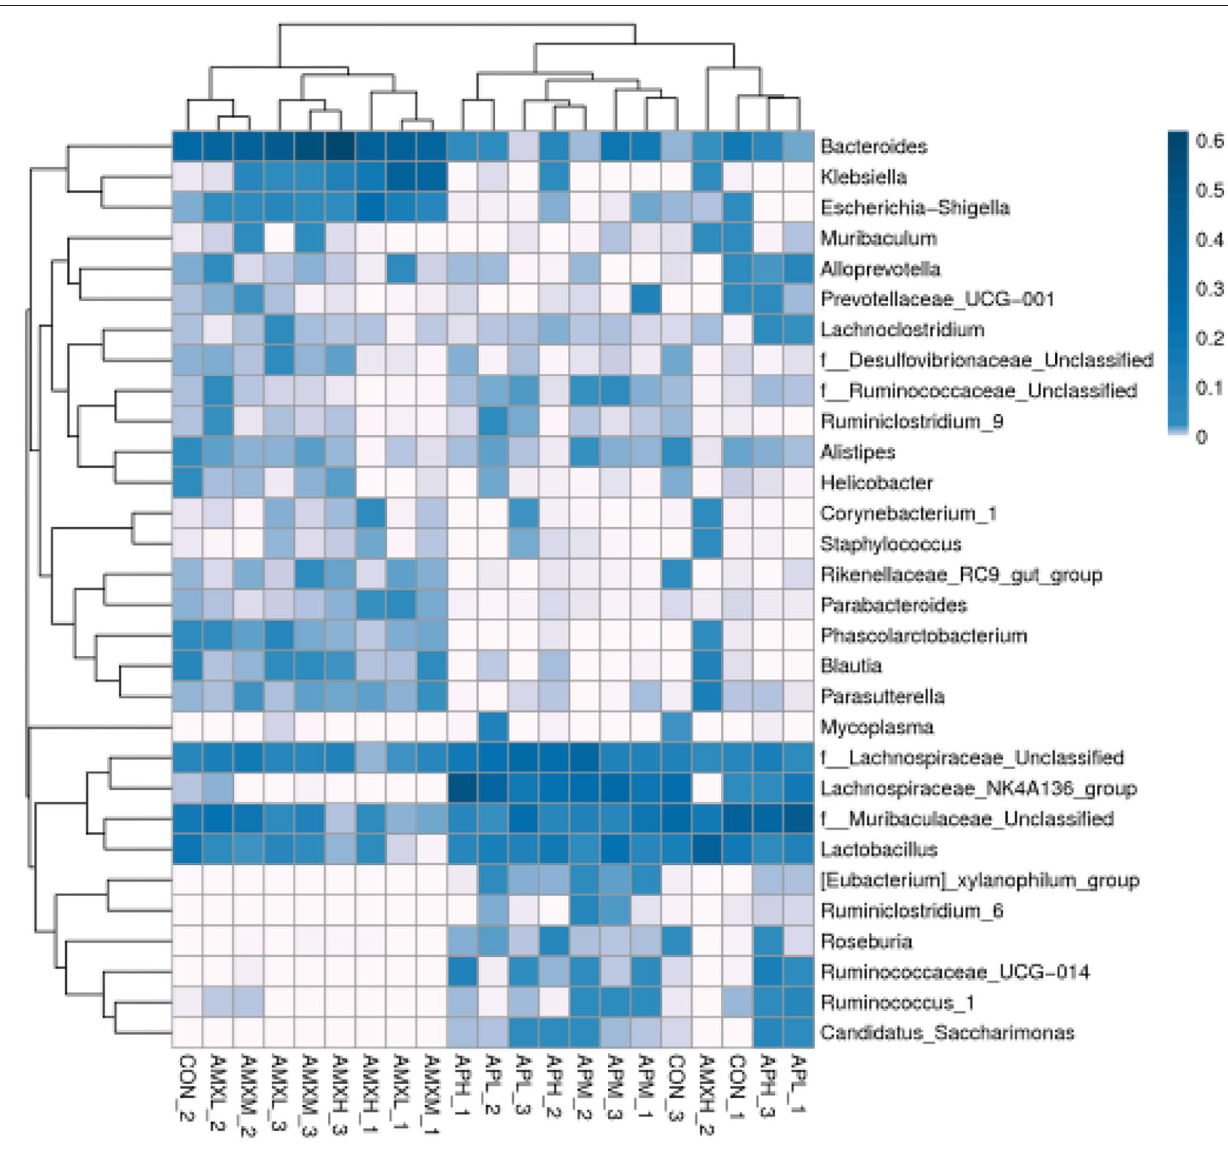
Frontiers in Veterinary Science |